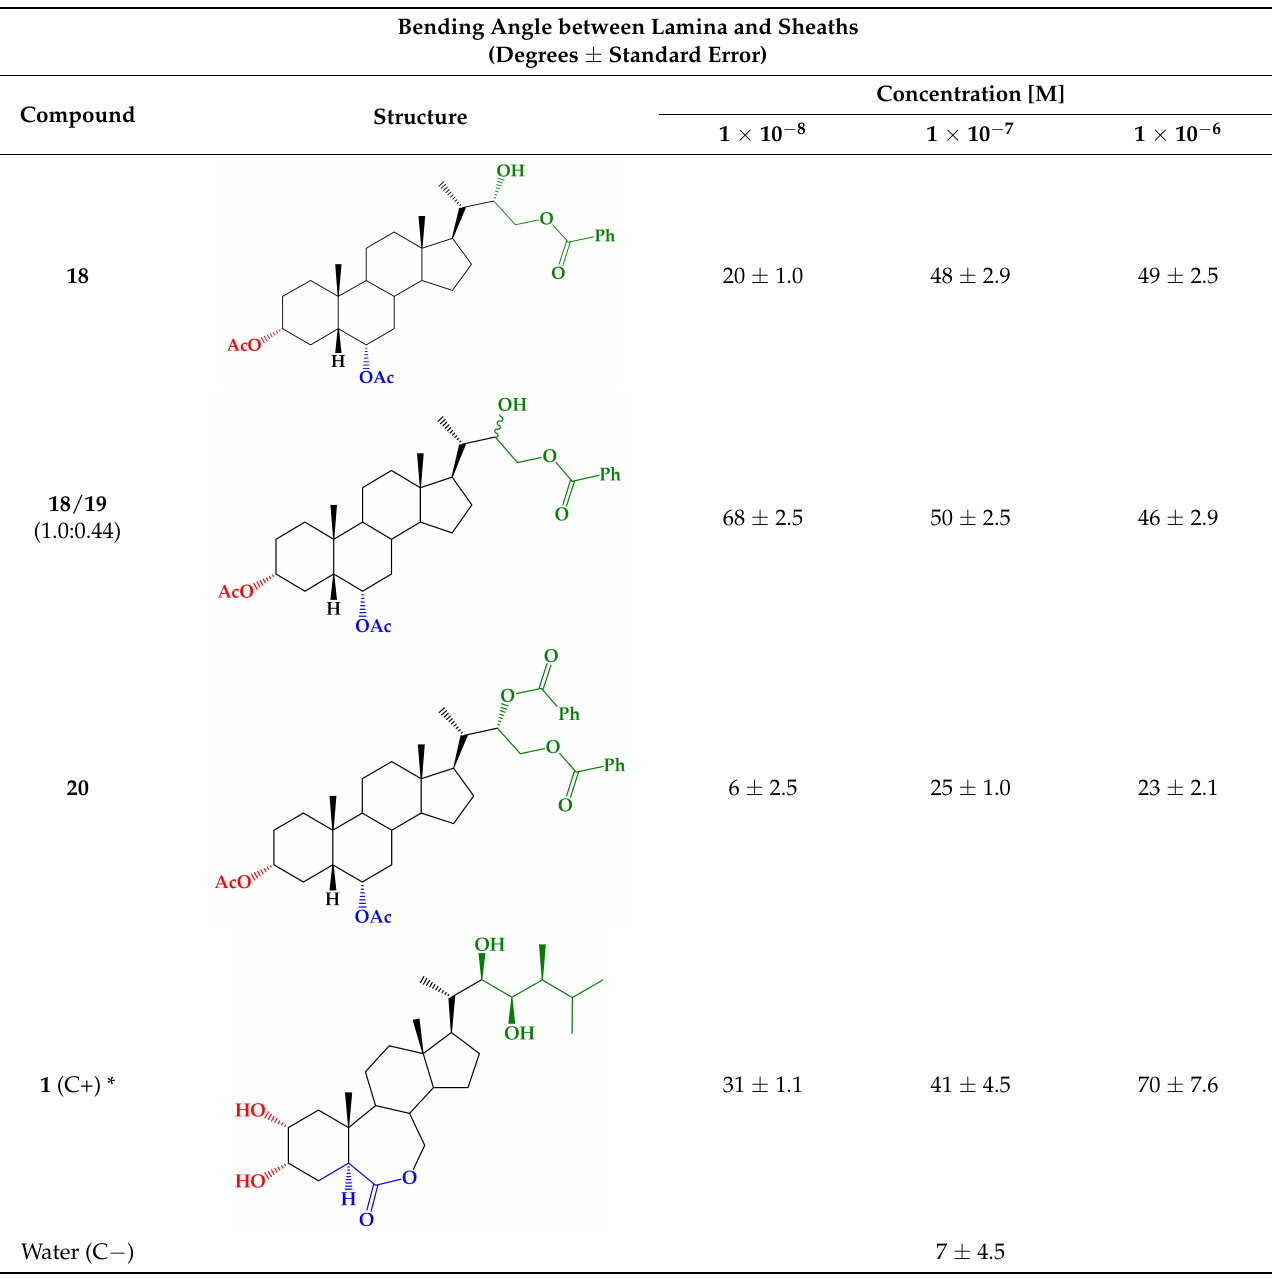
Table 3. Effect of compound 18 , epimeric mixture 18 / 19 and compound 20 on lamina inclination of rice